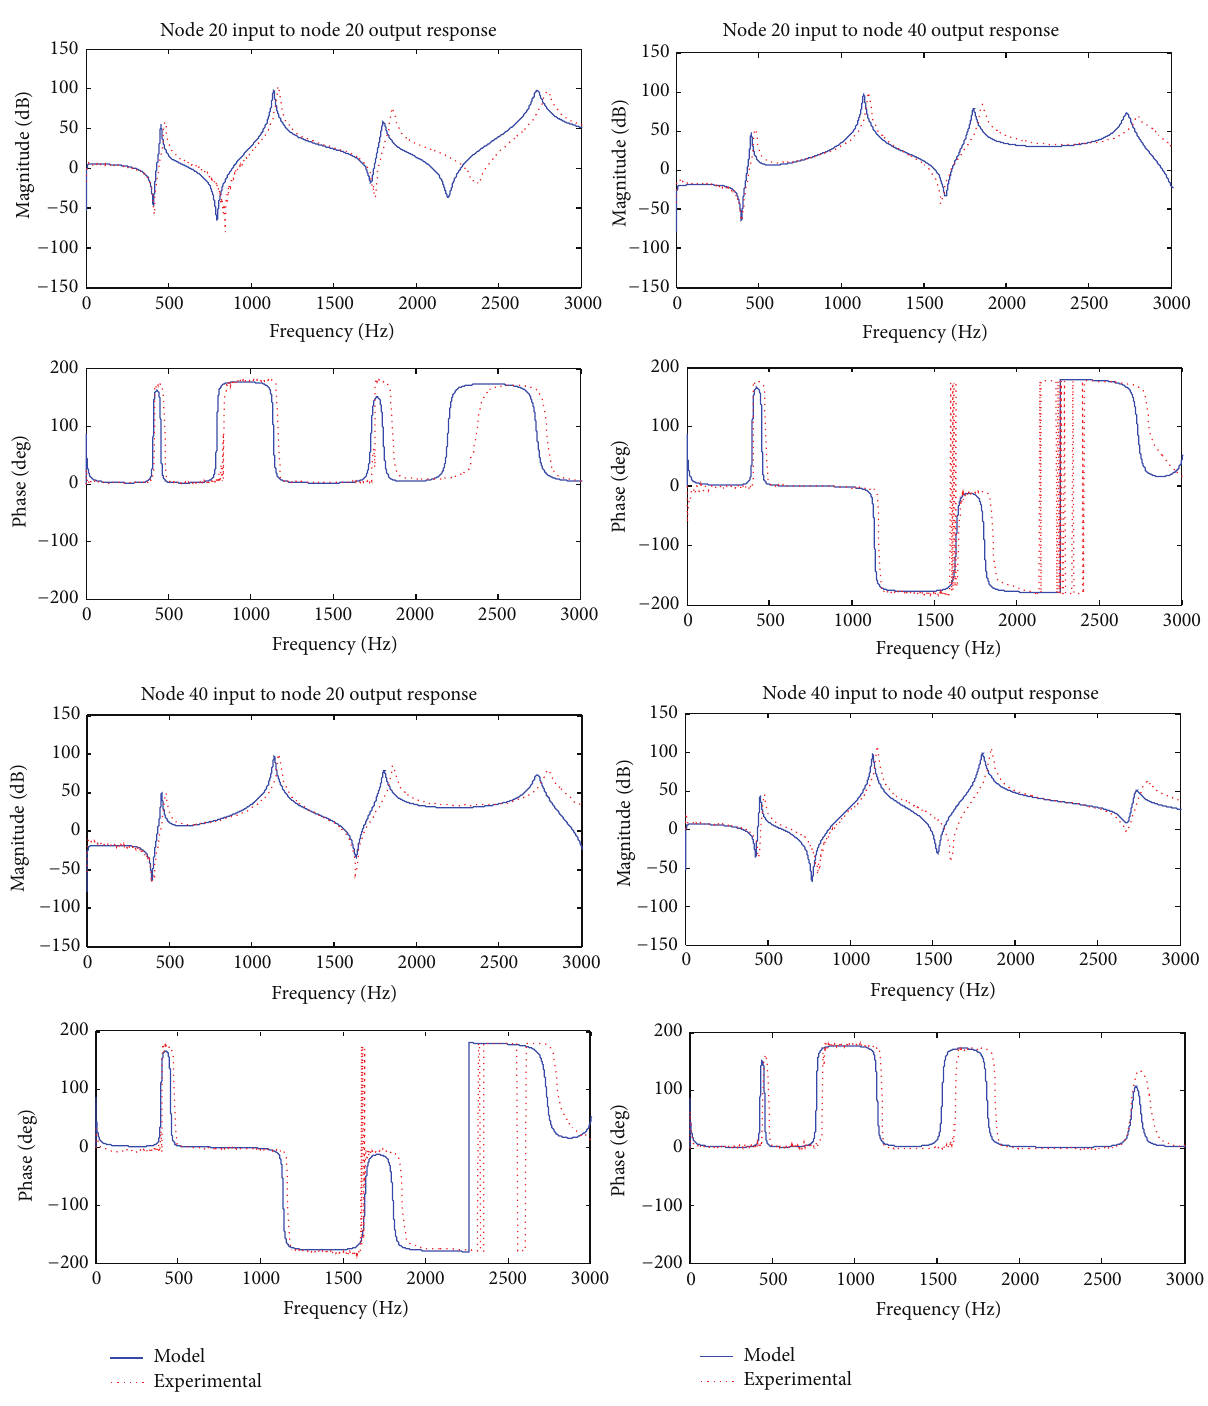
Figure 8: Experimental and nonupdated model frequency response